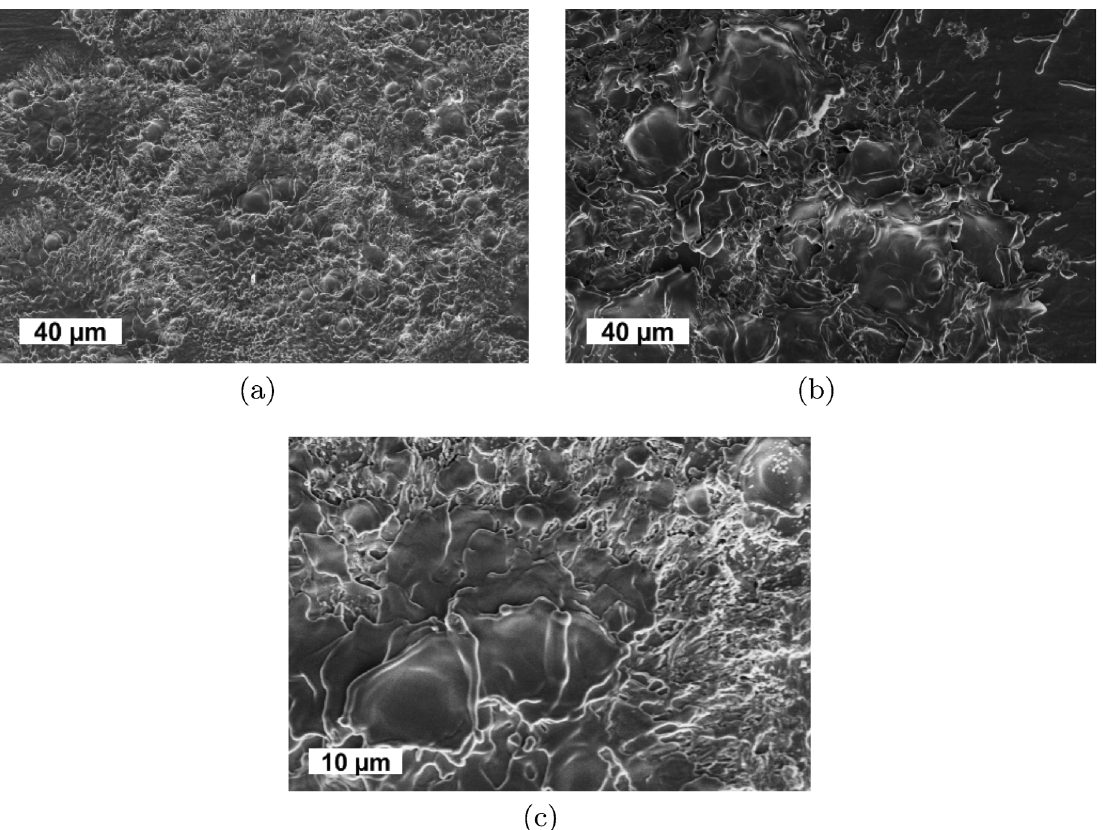
FIG. 7. SEM images of surface damage for Cu for low and high energy regimes. When scaled to the same energy flux, low and high energy regimes exhibit visual self-similarity. (a) Surface damage for C 1 ¼ 0 : 56 nF ( (cid:2) 5 mJ ); the total number of sparks on the spot was 131. (b) Surface damage for C 1 ¼ 27 : 5 nF ( (cid:2) 90 mJ ); the total number of sparks on the spot was 125. (c) Surface damage for ¼ 0 : 56 nF ( (cid:2) 5 mJ ); magnified by a factor of C 1